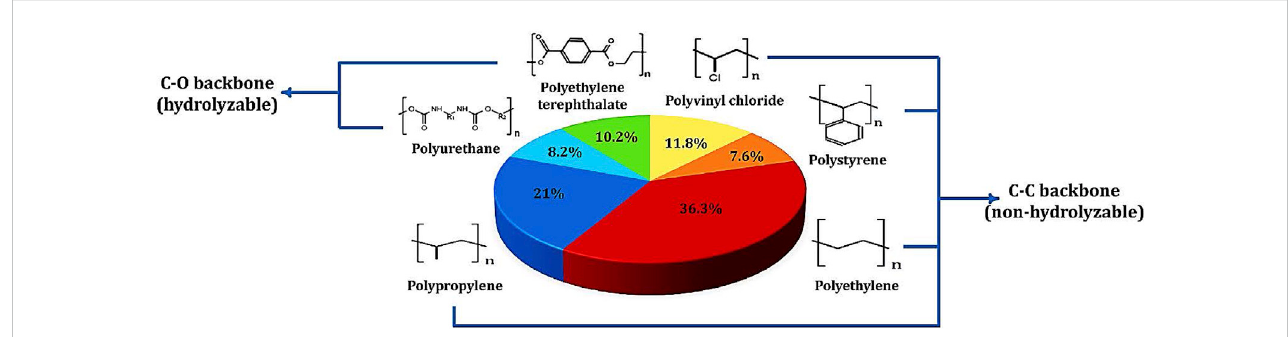
FIGURE 1 Forms of synthetic plastics and percentage distribution of their market share (Ali et al.,